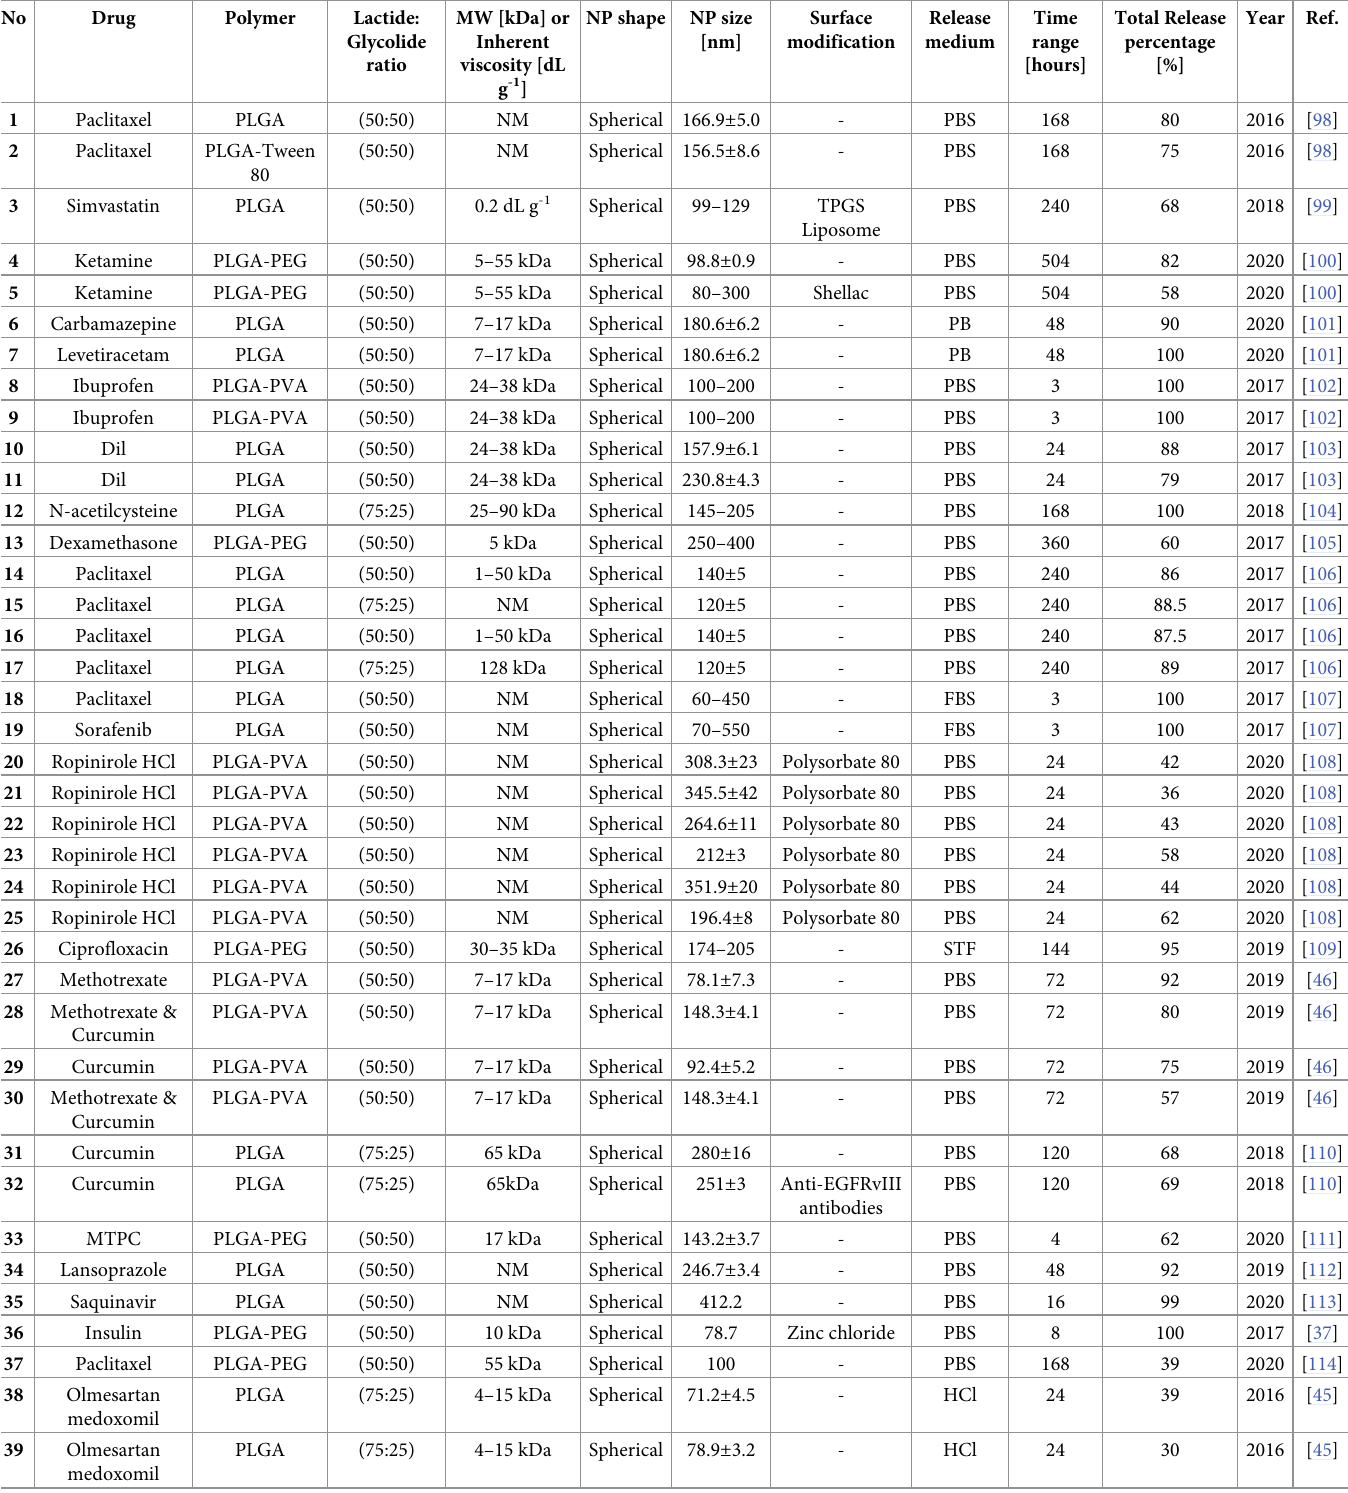
Table 1. Main characteristics of the 40 datasets